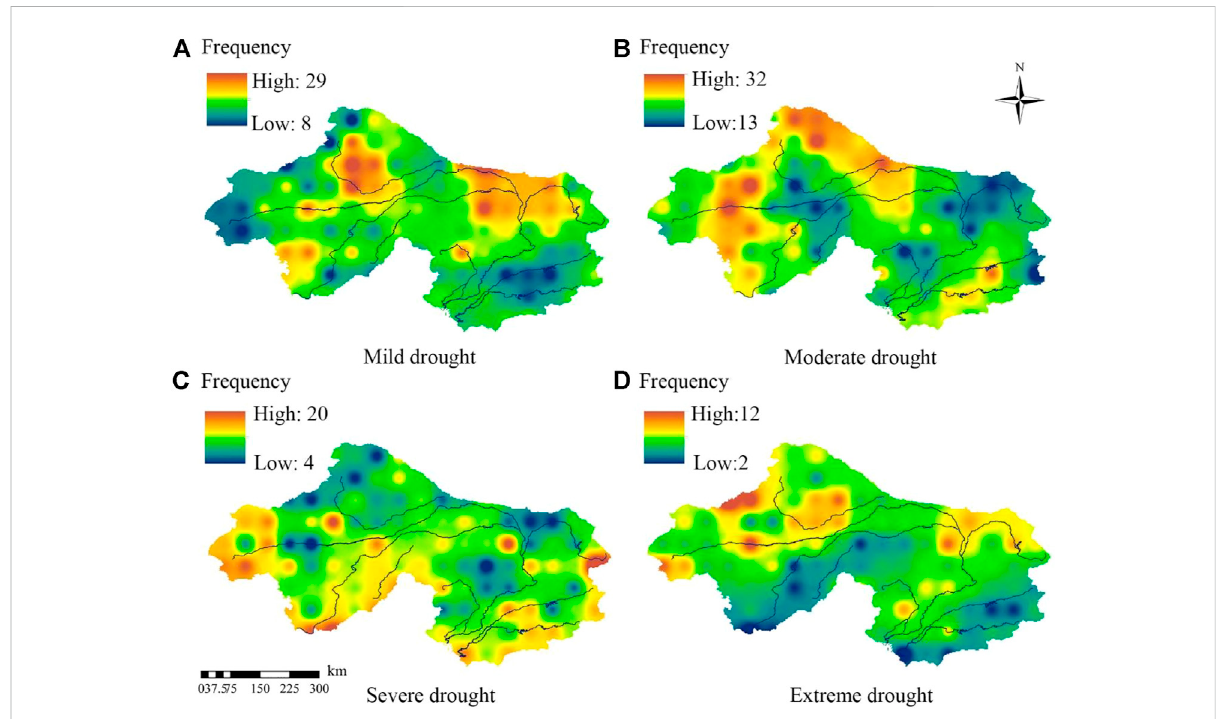
FIGURE 4 Spatial frequency distribution of different grades of droughts from 1962 to 2019. (A) is mild drought, (B) is moderate drought, (C) is severe drought, (D) is extreme